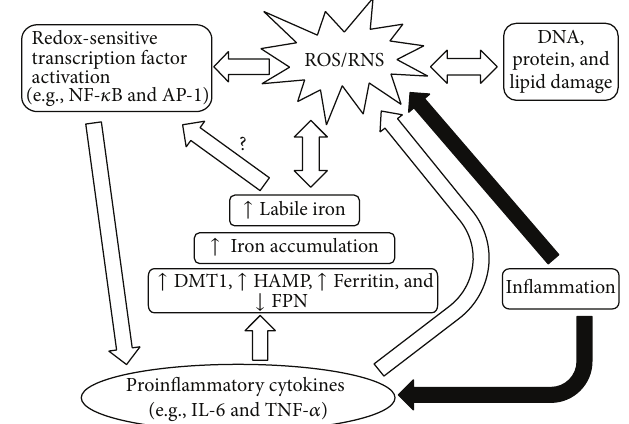
Figure 2: Putative involvement of iron in inflammation. Inflammation induces the production of proinflammatory cytokines which can induce the sequestration of iron within cells through the modulation of iron regulatory protein expression (e.g., divalent metal transporter 1 (DMT1), hepcidin (HAMP), ferritin, and ferroportin1 (FPN)). Increased iron levels, especially in macrophages, may lead to ROS production via the Fenton and Haber-Weiss reactions. ROS in return can increase levels of labile iron and induce oxidative damage of DNA, proteins, and lipids. Additionally, ROS can activate redox-sensitive transcription factors whose targets include proinflammatory